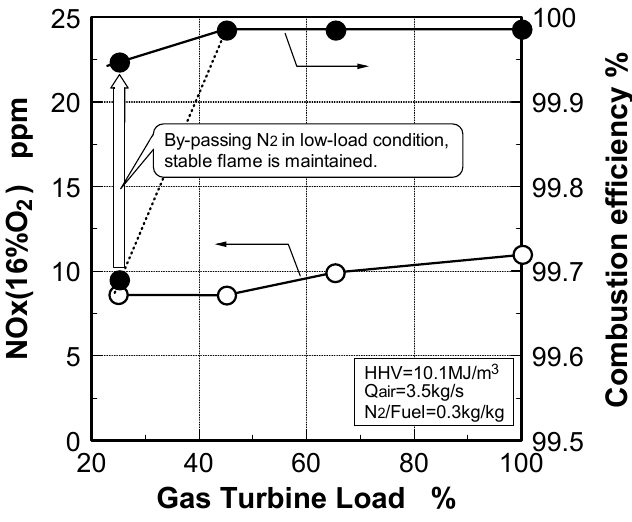
Figure 74. Effect of gas turbine load on combustion emission